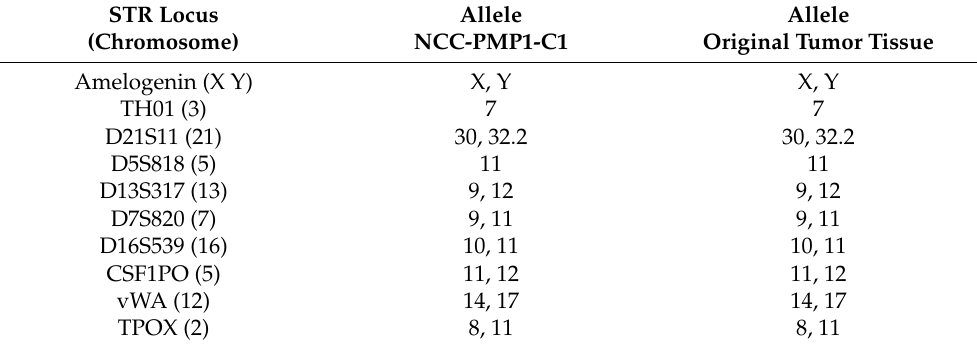
Table 1. Examination of short tandem